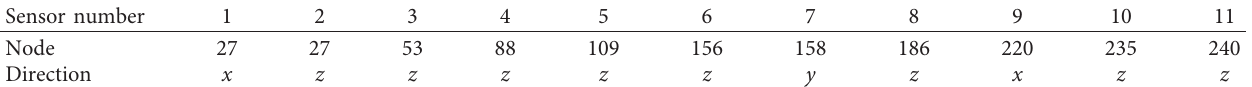
Figure 18: Optimal sensor placement of DGSA. Table 4: Optimal sensor locations of GA.